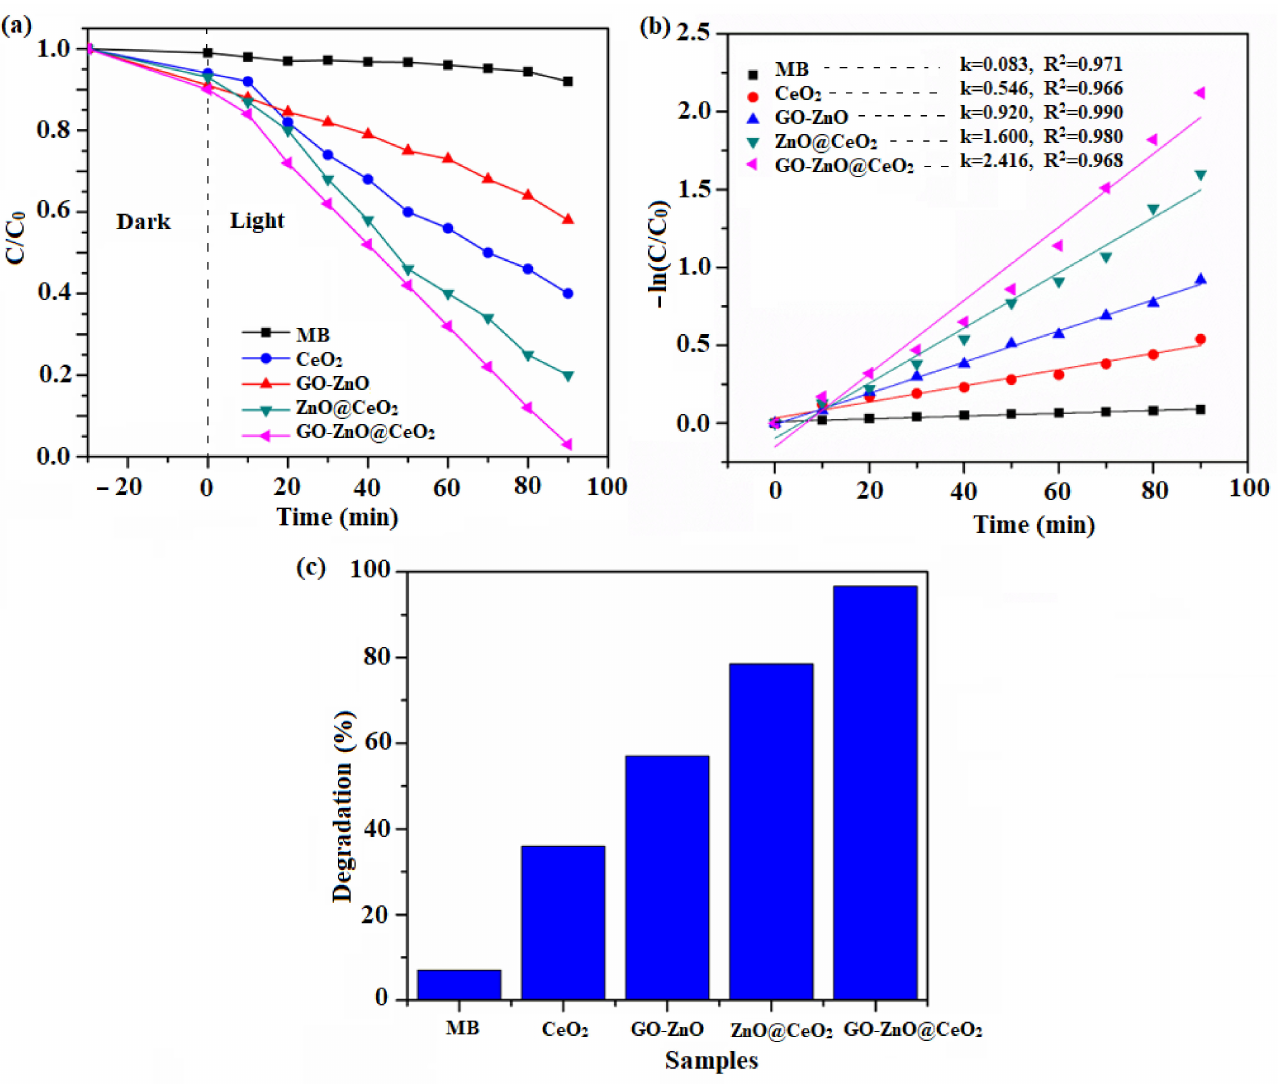
Figure 6. MB dye degradation. ( a ) Plots of irradiation time vs. efficiency, ( b ) pseudo-first-order kinetics and ( c ) degradation